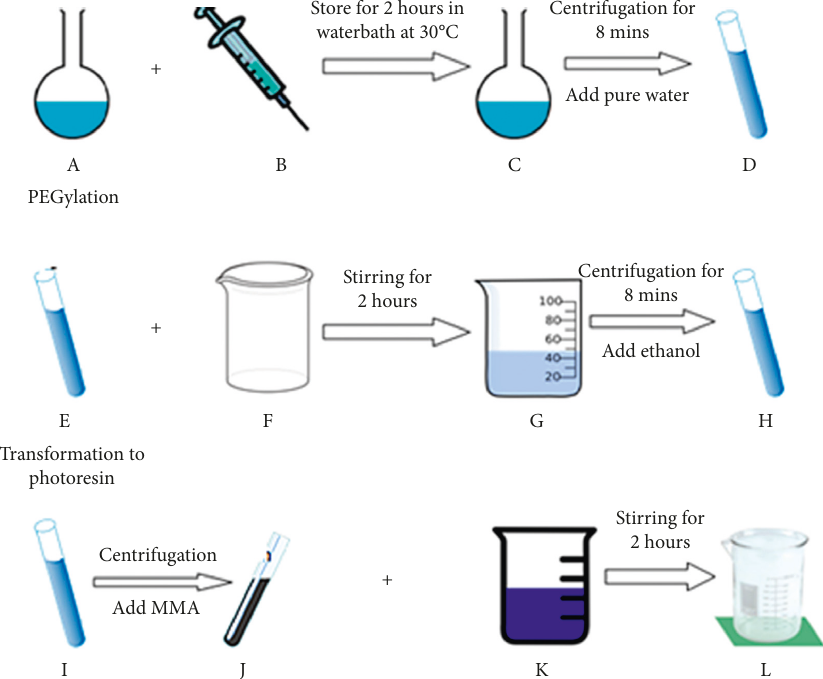
Figure 6: (A) Growth solution: CTAB, HAuCl 4 , AgNO 3 , H2SO 4 , and AA. (B) Seed solution: CTAB, HAuCl 4 , and NaBH 4 . (C) Gold nanorods dispersed in pure water. (D) Redispensation of gold nanorods in pure water. (E) Gold nanorods dispersing in water. (F) mPEG-SH solution. (G) Gold nanorods wrapped in mPEG-SH, in pure water. (H) Gold nanorods wrapped in mPEG-SH, dispersing in ethanol. (I) Gold nanorods dispersing in ethanol. (J) Gold nanorods dispersing in MMA. (K) Photopolymerisation resin. (L) Gold nanorods dispersing in photoresin.